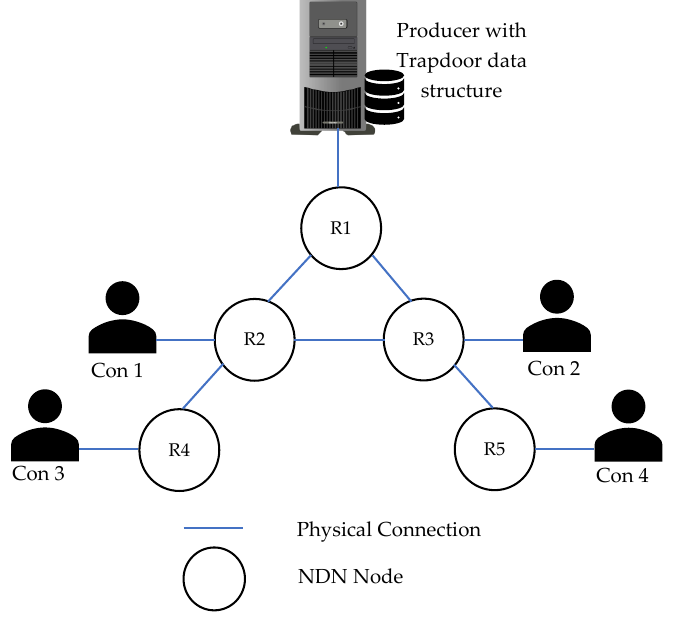
Figure 10. Experimental